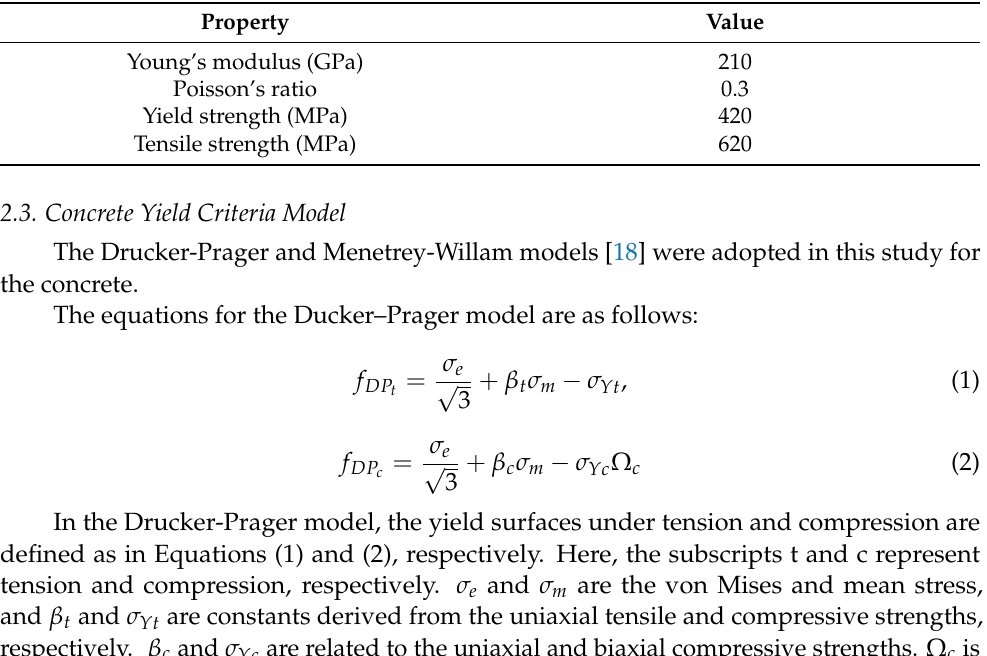
Table 3. Material properties of ASTM A615 Grade